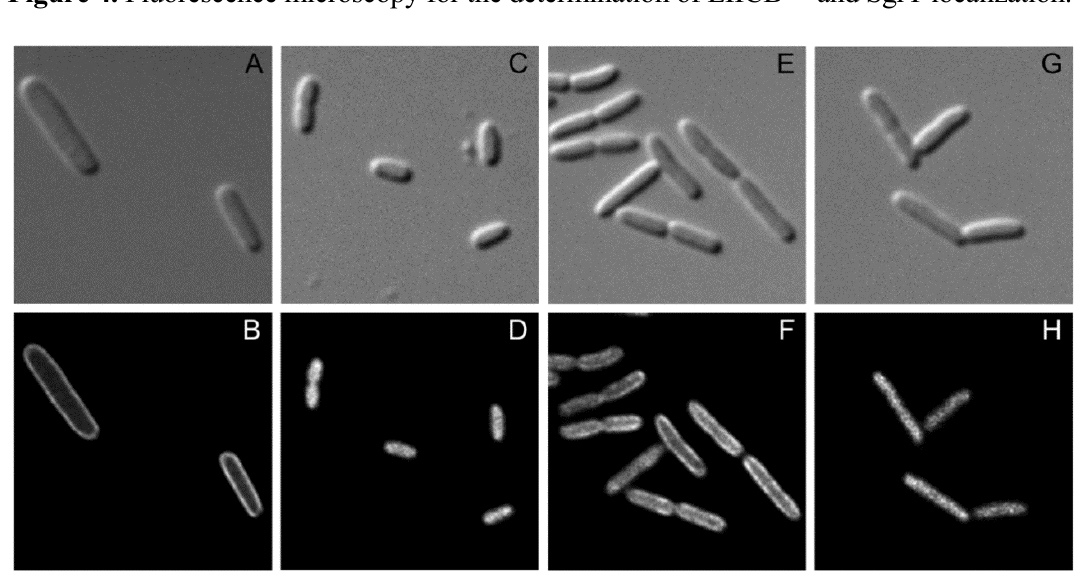
Figure 4. Fluorescence microscopy for the determination of EIICB Glc and SgrT